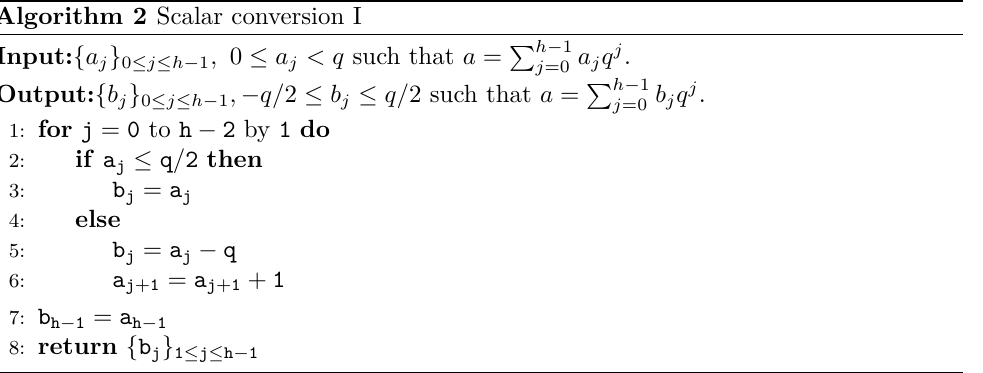
Algorithm 2 Scalar conversion I